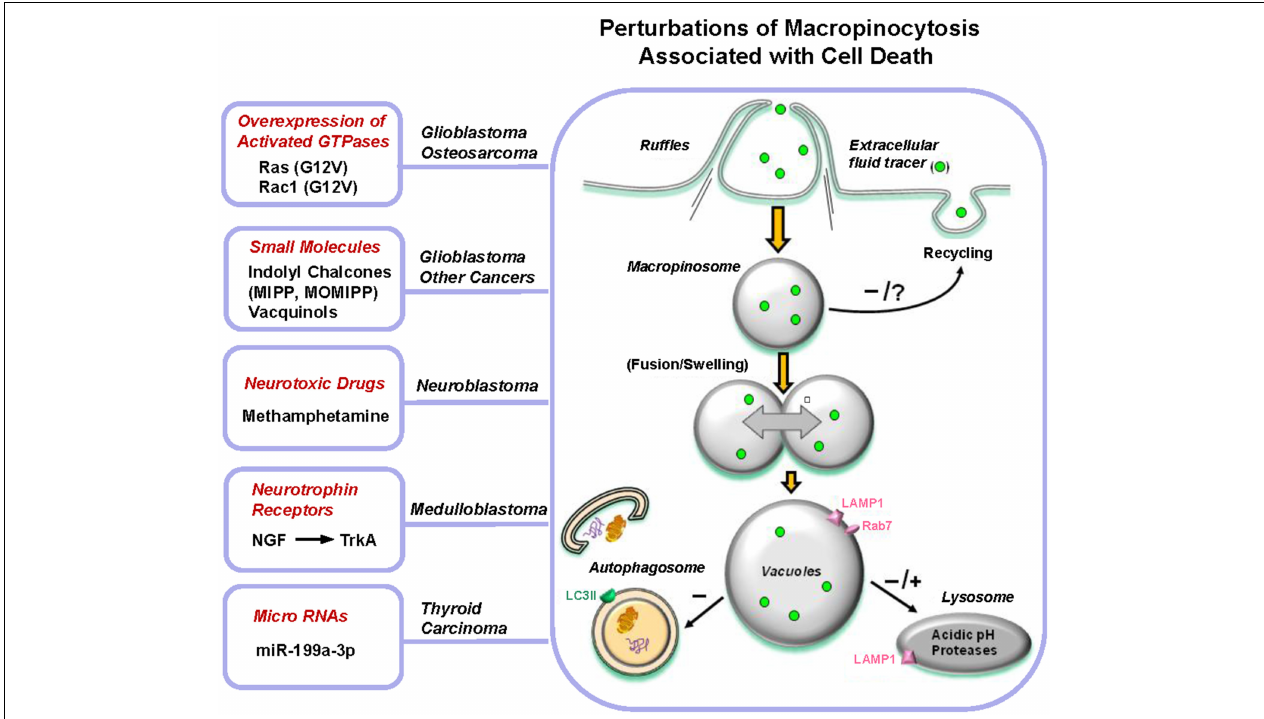
FIGURE 2 | Perturbations of macropinocytosis associated with cell death. A molecular or pharmacological stimulus triggers a vigorous increase in membrane ruffling and formation of macropinosomes. This may be sustained (as in Ras or TrkA stimulation) or transient (MIPP treatment). Once generated, the incoming macropinosomes give rise to a multitude of large vacuoles that fill much of the cytoplasmic space. Studies with MIPP indicate that vacuole enlargement occurs through fusion events, although osmotic swelling has not been ruled out conclusively in most cases. Defective recycling of macropinosomes contributes to vacuole formation in specific instances (Ras or Rac overexpression, treatment with MIPP), but this has not